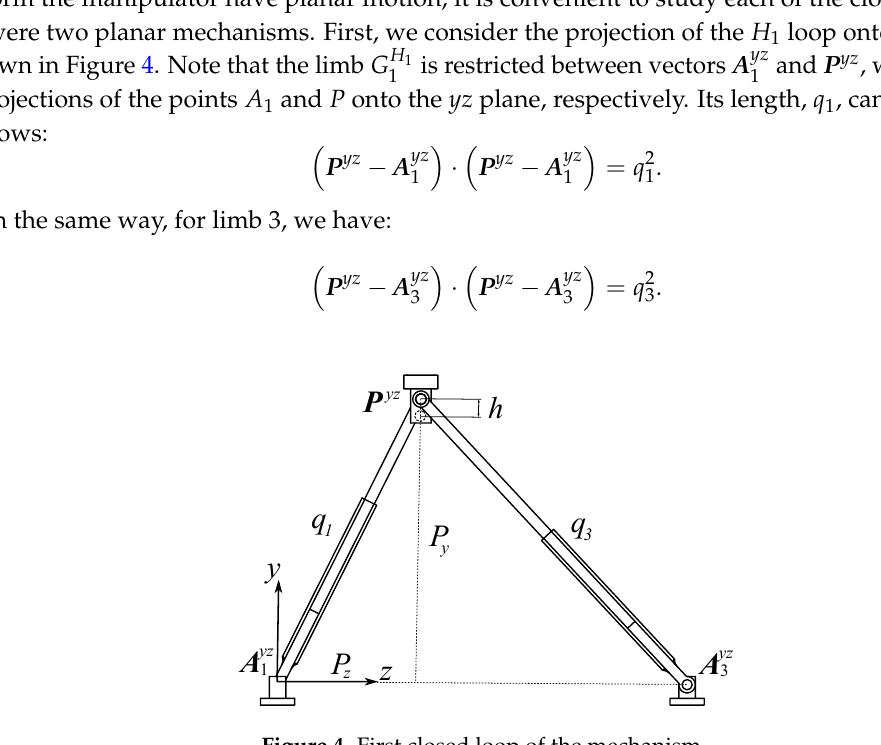
Figure 4. First closed loop of the